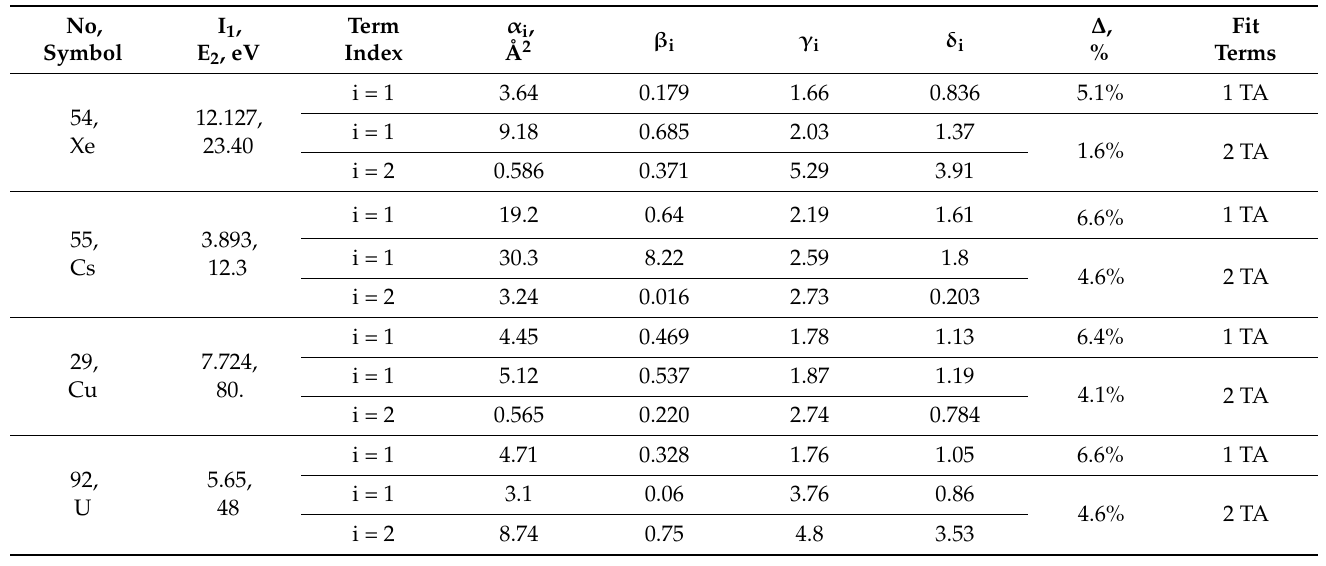
Table 6. Values of parameters for the ionization cross sections approximation of atoms of Xe, Cs, Cu, U: one − term approximation (1 TA) by Formula (6) and two − term approximation (2 TA) by Formula (7).